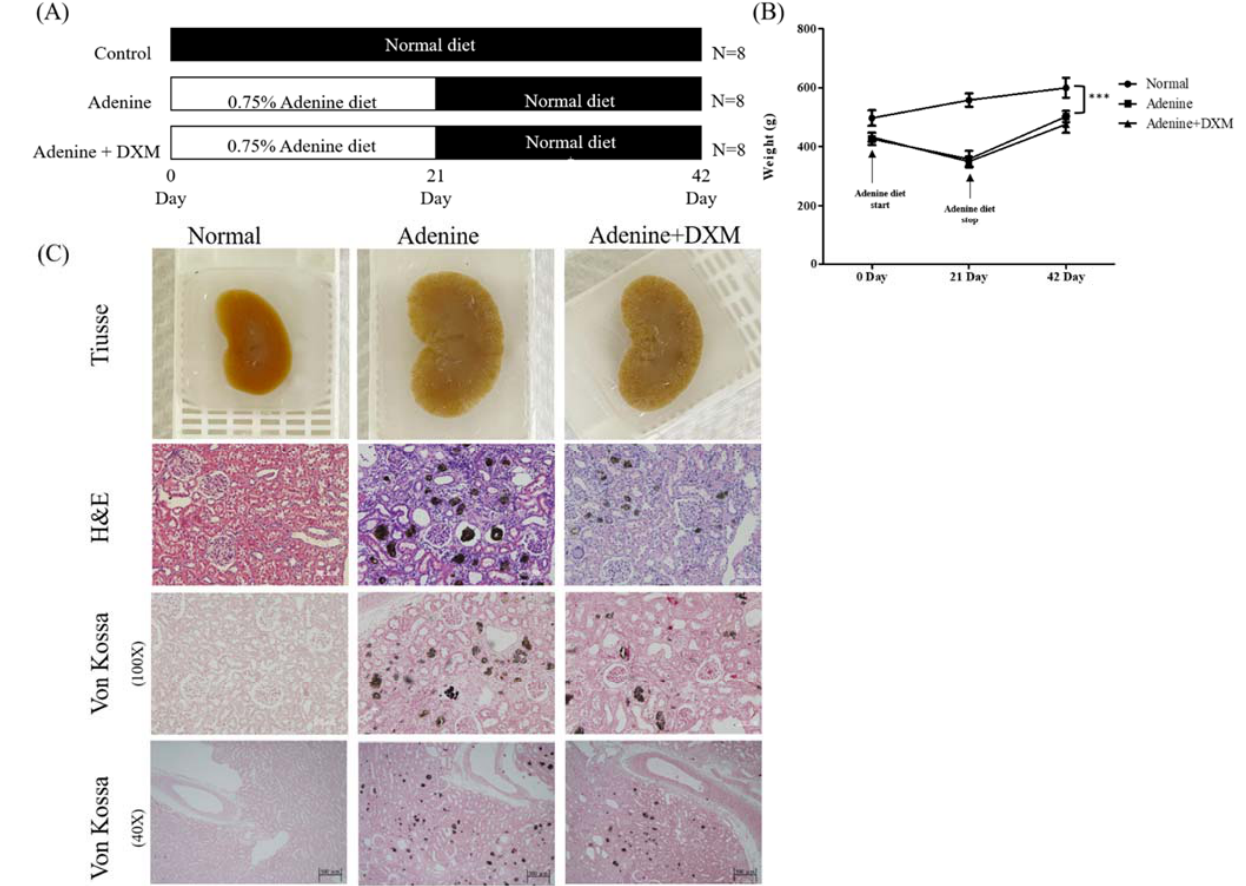
Figure 3. Effects of DXM on human aortic vascular smooth muscle cells with the high-phosphate medium (n = 3). ( A ) Alizarin red S staining was employed to assess calcification in the vascular smooth muscle cells. ( B ) Statistical analysis of calcification on each group. Not significant: ns, ** p < 0.01. Abbreviations: high-phosphate medium (HP); apocynin (APO).